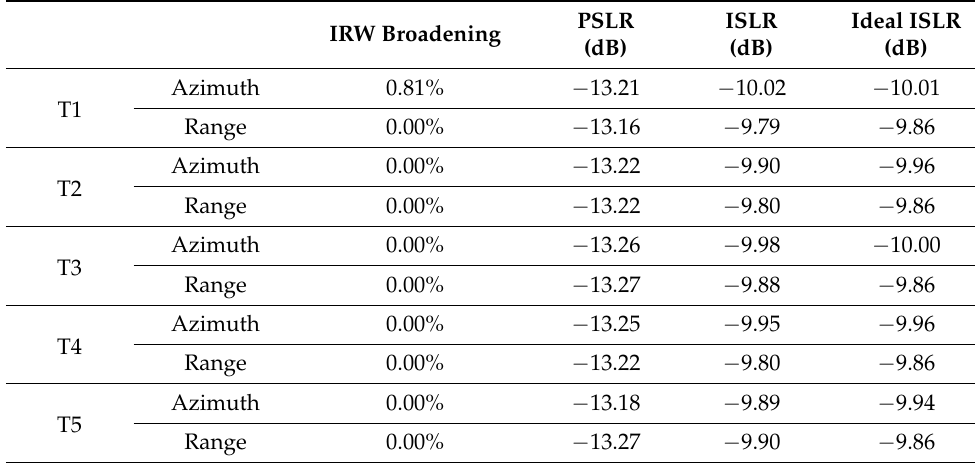
Table 4. Measured image quality